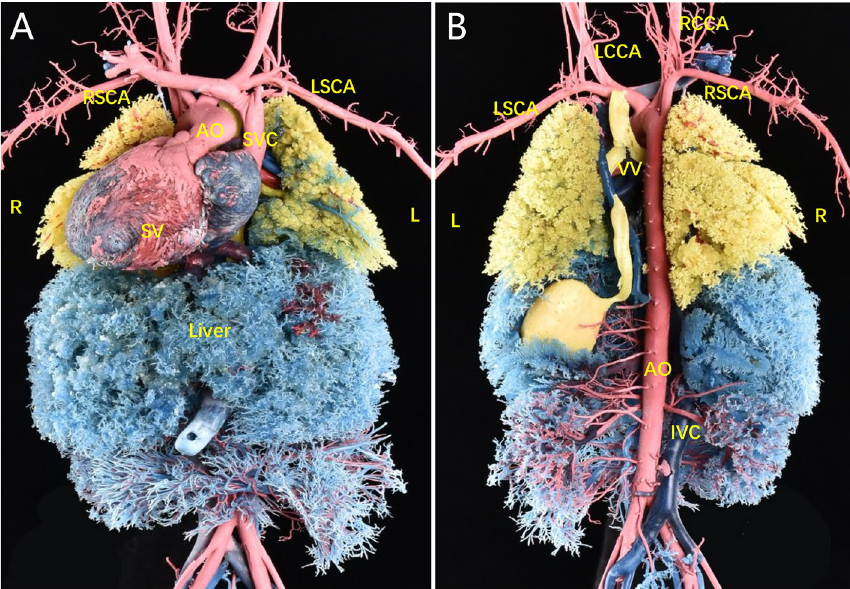
Figure 4. Confirmation of the prenatal diagnosis based on the cardiovascular cast. ( A , B ) The cast revealed dextrocardia, a single ventricle, isolated left superior vena cava, right aortic arch with mirror branches, and anomalous complete drainage of the PV into the left superior vena